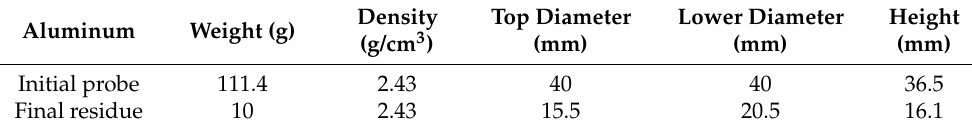
Table 2. Dimensions of the aluminum test piece and the residue from the first